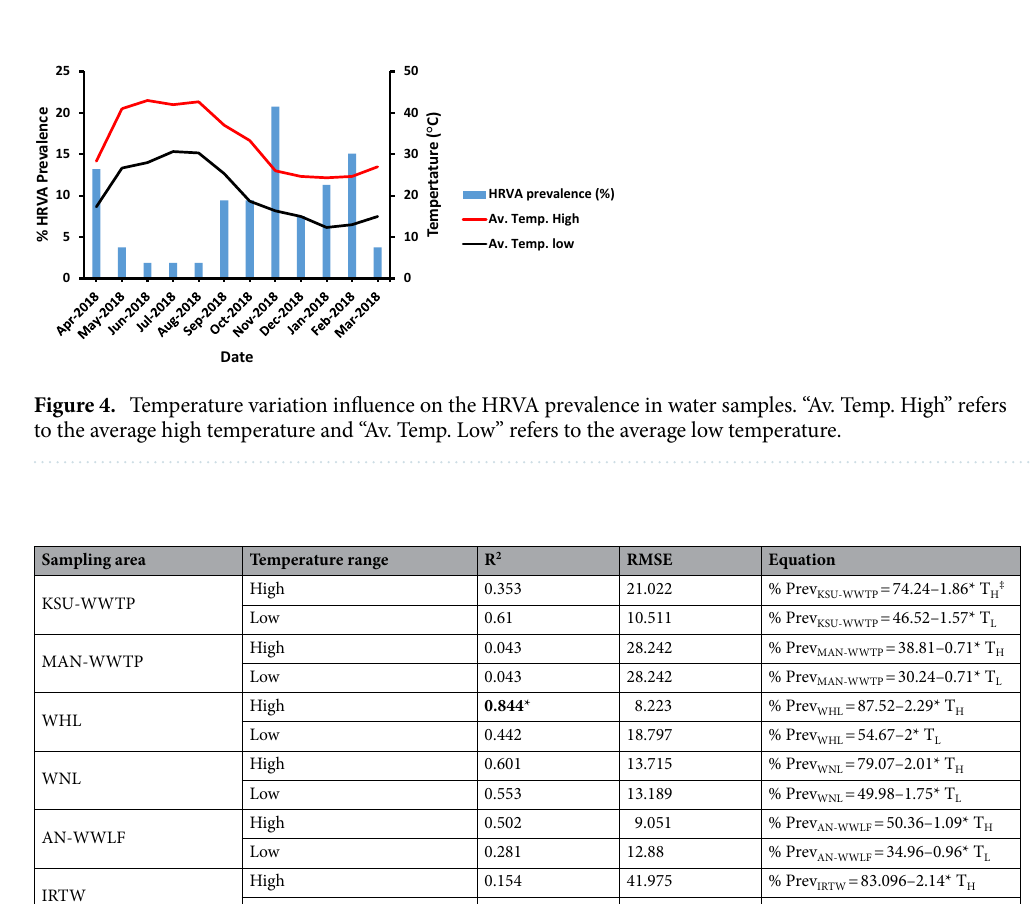
Table 3. Pearson’s correlation matrix of HRVA detection percentage at the various sampling areas. The numbers above the grey-highlighted diagonal refers to correlation values at high-temperature range, whereas correlation values at low-temperature range are below the diagonal. % Det denotes HRVA detectability percentage at different sampling areas, for instance % Det KSU-WWTP refers to HRVA detection percentage at KSU-WWTP. *Significant correlation values are displayed as bold numbers.